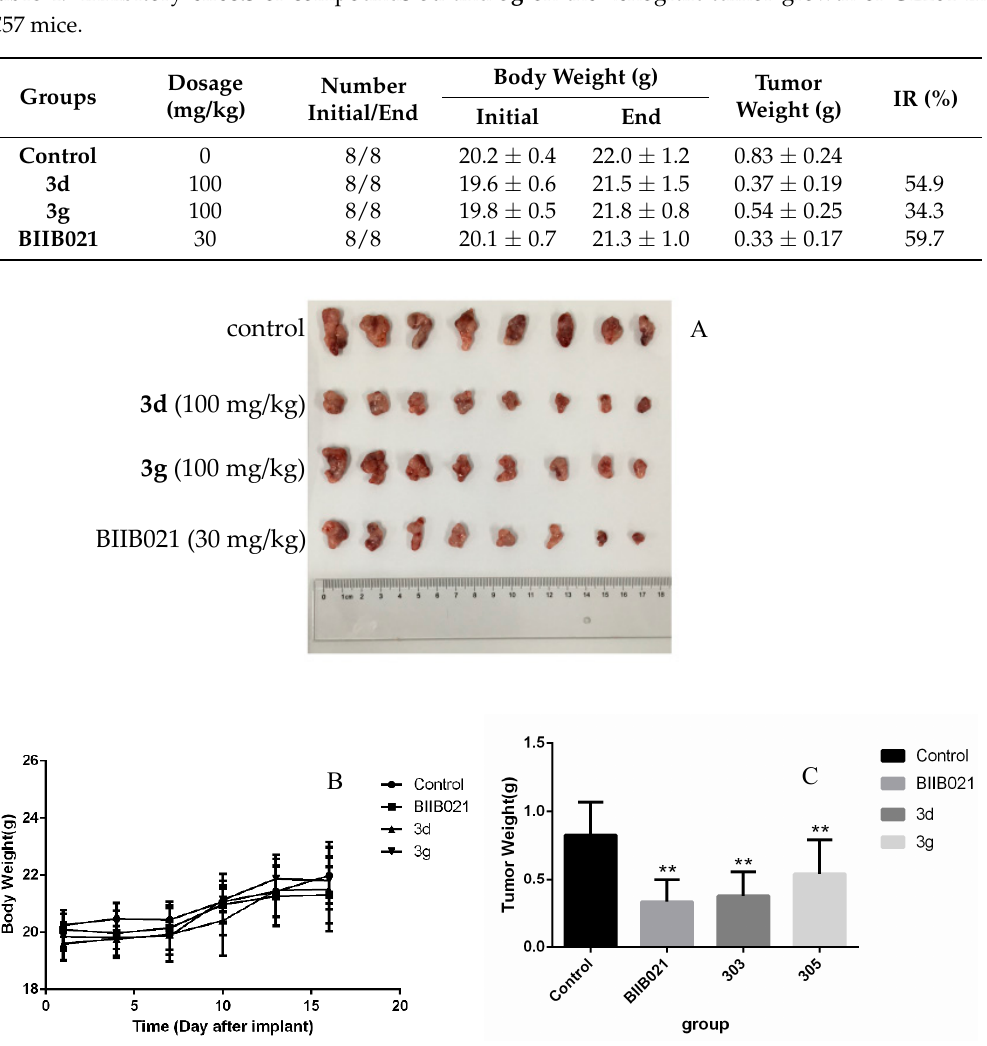
Figure 2. Effects of compounds 3d and 3g on the antitumor activity of GL261 xenograft tumors in C57 mice. ( A ): The tumors were stripped and photographed the experimental results after two weeks. ( B ): The body weight of the four groups of mice was changed for two weeks. ( C ): The tumor of the four groups of mice was weighed after two weeks. ** p < 0.01, compared with control group. Table 4. Inhibitory effects of compounds 3d and 3g on the xenograft tumor growth of GL261 in C57 mice.